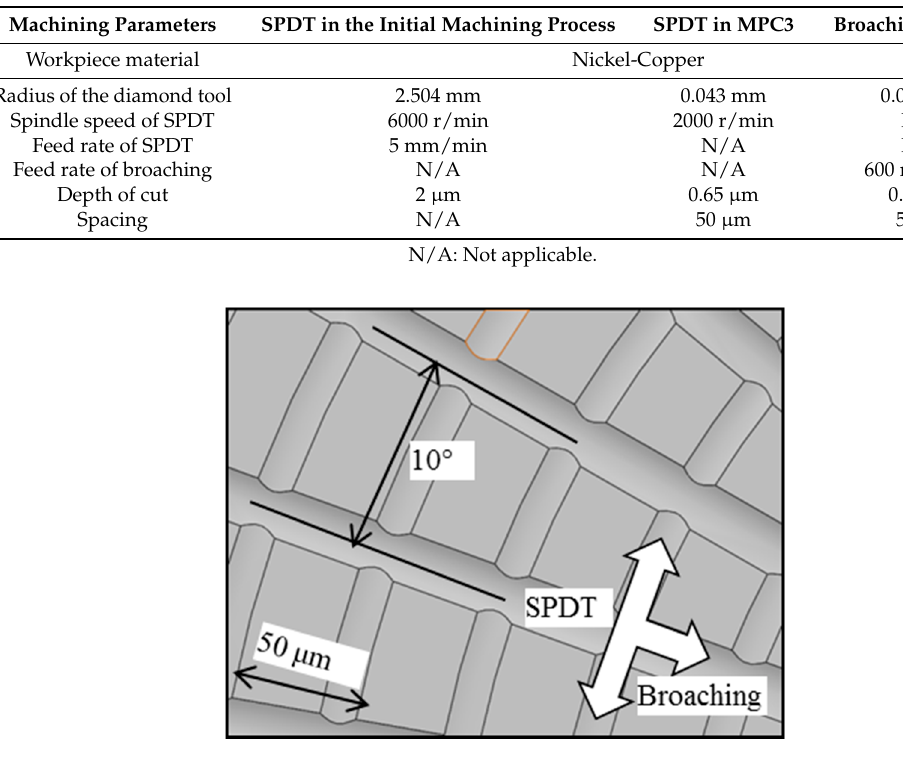
Table 2. Machining parameters in the manufacturing of micro polar structure.